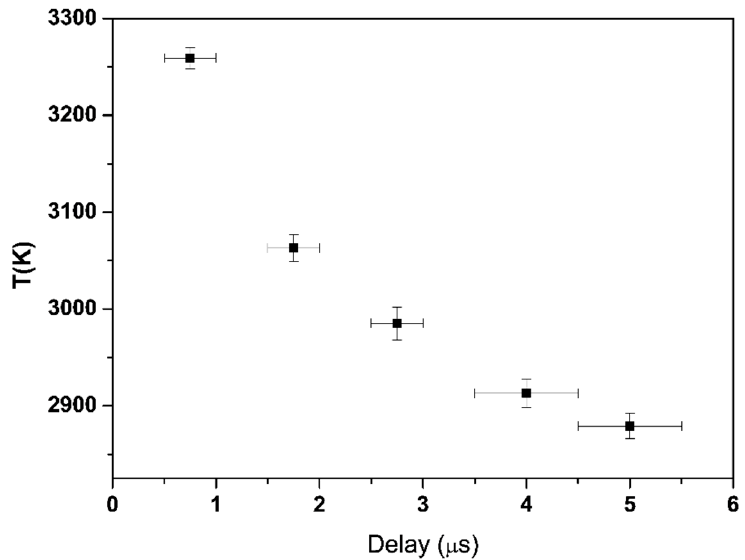
Figure 10. Temporal evolution of the temperature of the secondary plume front obtained by OES data.